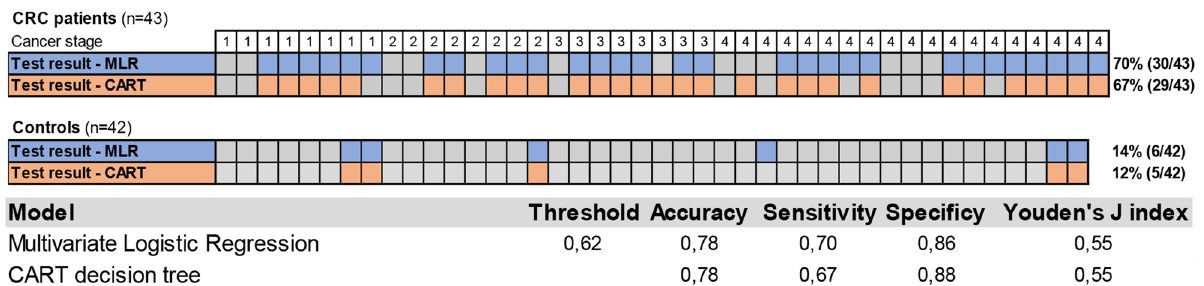
Figure 5. The performance of both generated models and their accuracy in detection of CRC in supernatant urine. The figure shows the classification of CRC samples and controls for both MLR and CART models. At the bottom, performance specifics for both models are